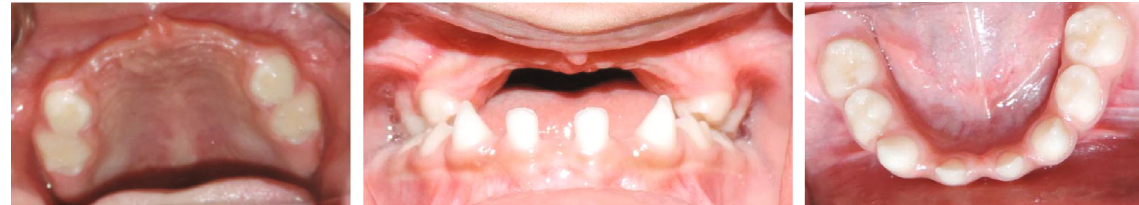
Figure 1: Intraoral pictures demonstrating multiple missing teeth.